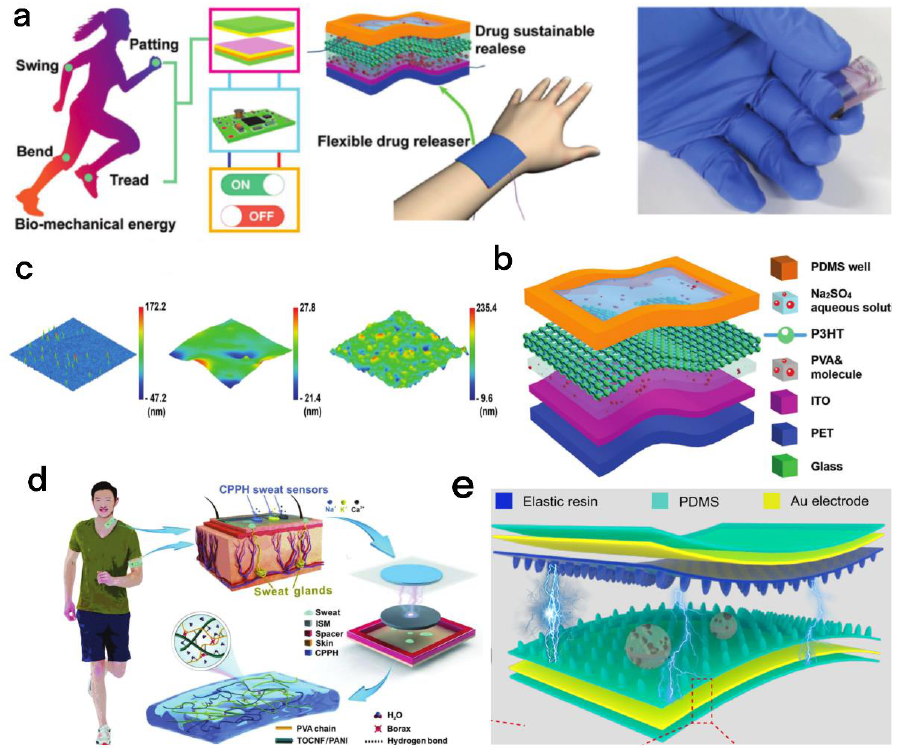
Figure 12. ( a ) The TENG collects biomechanical energy to provide power for the FDRD. ( b ) Structure of the FDRD. ( c ) The surface morphology of the ITO layer, the PVA molecular layer, and the P3HT layer was recorded with an atomic force microscope (AFM) [87]. Liu et al. (2020), John Wiley and Sons Inc. ( d ) Cellulosic conductive hydrogel for self-powered sweat measurement, CPPH electrode material, microstructure diagram, and CPPH sweat sensor module structural diagram. During body movement, the sweat sensor monitors the concentration of sweat ions in real time. The CPP sweat sensor is placed on the skin’s sweat glands to detect and quantify Na + , K + , and Ca 2+ [88]. Qin et al. (2022), John Wiley and Sons Inc. ( e ) Schematic structure of the BSRW-TENG [89]. Li et al. (2022),